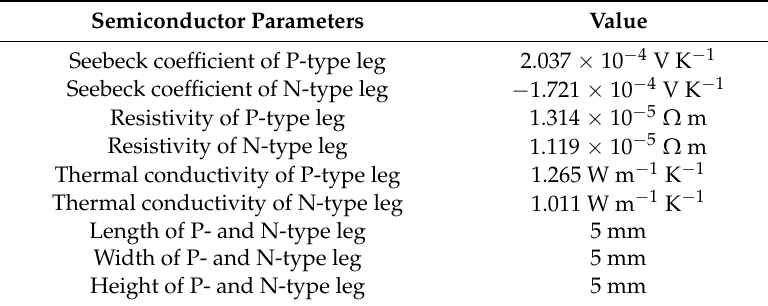
Table 1. Basic calculation parameters of thermoelectric